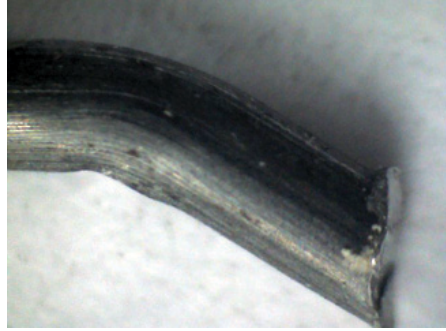
Fig. 2. Magnified (125 times) ending of the steel